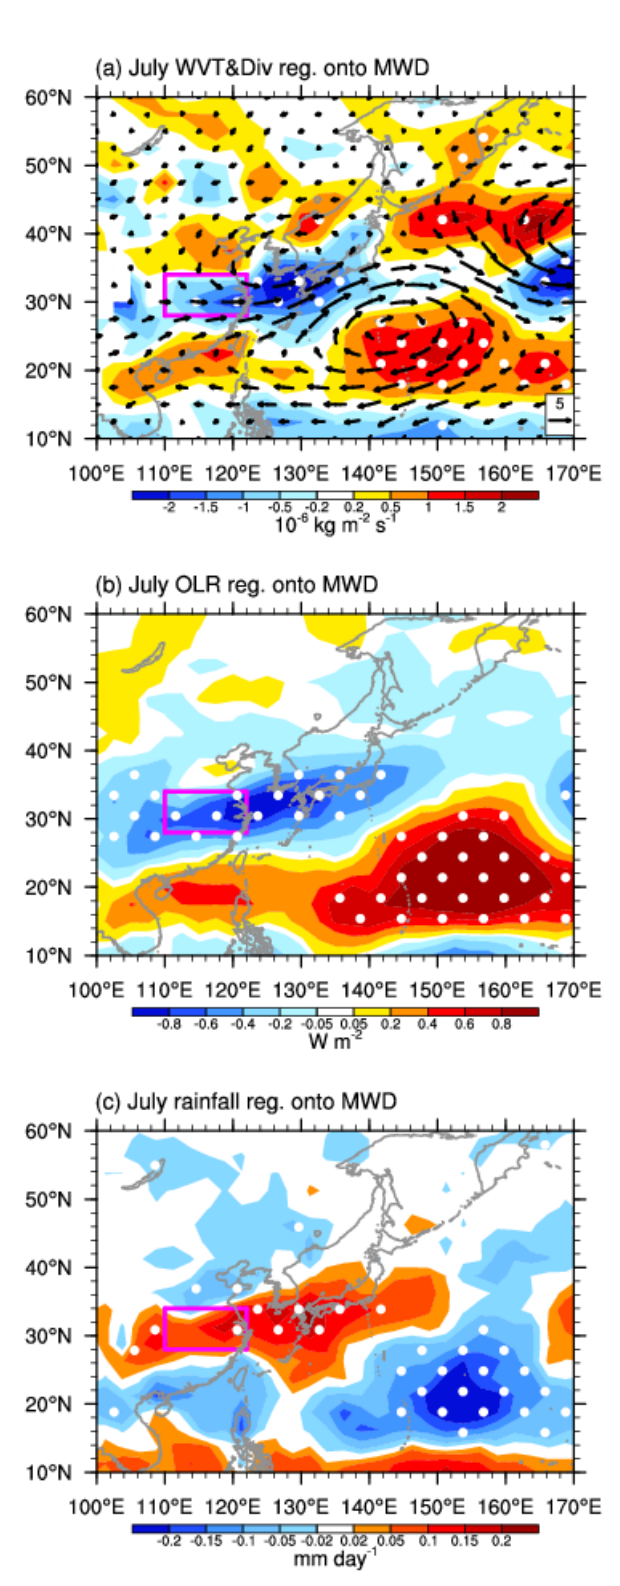
Figure 3. Regressed anomalies of July–mean ( a ) vertically integrated WVT (vectors; unit: kg m − 1 s − 1 ) and WVT_div (shading; unit: 10 − 6 kg m − 2 s − 1 ); ( b ) OLR (shading; unit: W m − 2 ); and ( c ) precipitation (shading; unit: mm day − 1 ), with respect to the MWD departure in the YHRB during the period 1980–2016. U200, Z500, and UV850 anomalies that are significant at the 95% confidence level are stippled, and the magenta box denotes the research domain of the YHRB Meiyu region.